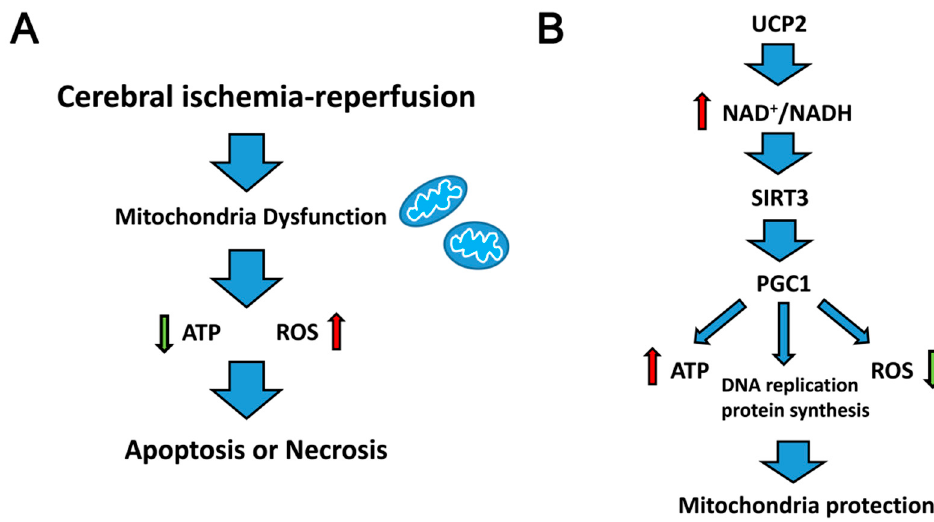
Figure 1. Proposed model for UCP2-SIRT3 (uncoupling protein 2-sirtuin 3) signaling pathway on cerebral ischemia–reperfusion injury. ( A ) Mitochondrial dysfunction caused by cerebral ischemia– reperfusion injury leads cells to death. ( B ) Protective mechanism of UCP2-SIRT3 signaling pathway on mitochondria damage.